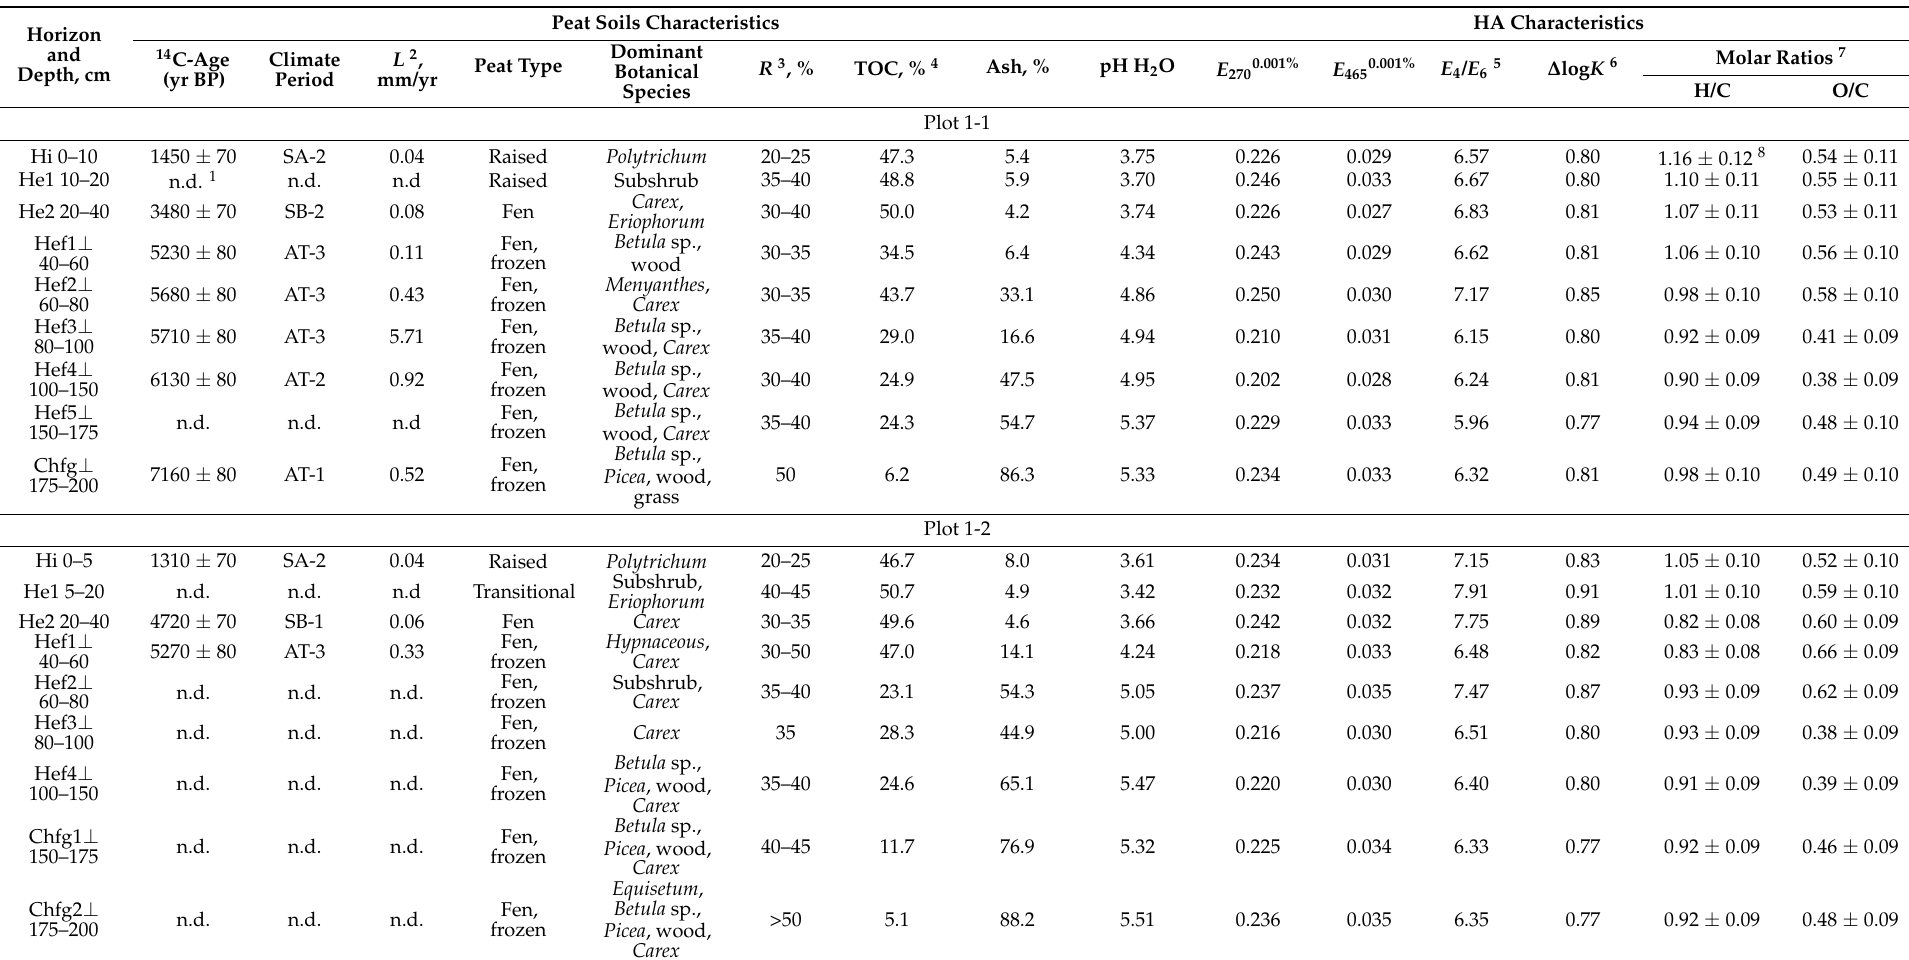
Table 1. Properties of raw peats and